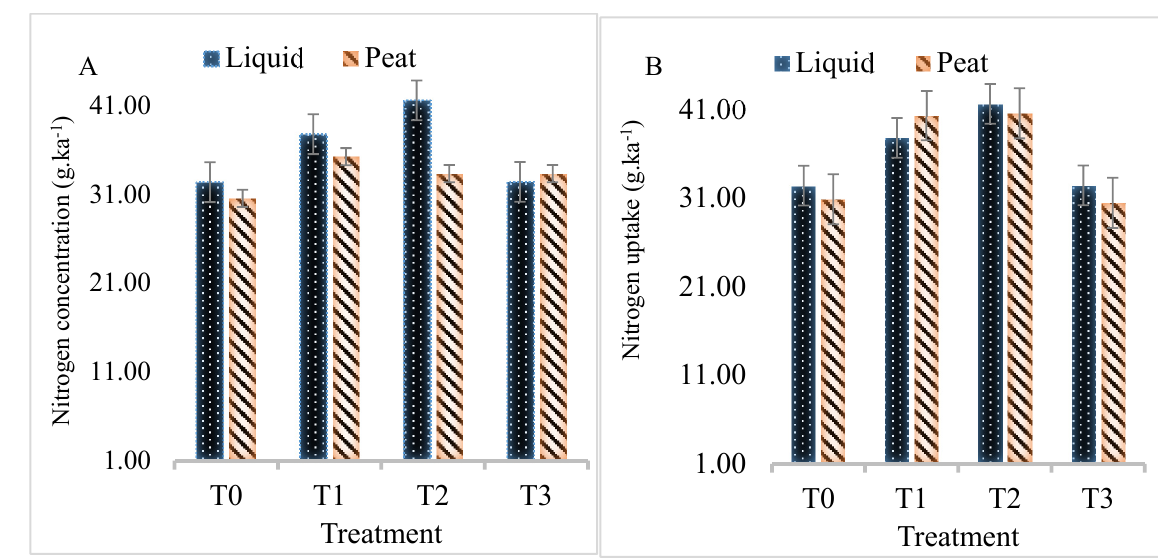
Figure 7. Nitrogen concentrate in soybean plants subjected to liquid formulation (T0 = 0 mL, T1 = 150 mL, T2 = 300 mL and T3 = 150 mL) and peat formulation of Bradyrhizobium japonicum (T0 = 0 mg, T1 = 250 mg, T2 = 500 mg and 150 mL) in bioclimatic zone (( A ) = Bronkhorspruit/Gauteng) and (( B ) = Hartbeesfoein/North West province). Data are means ± stand- ard errors.